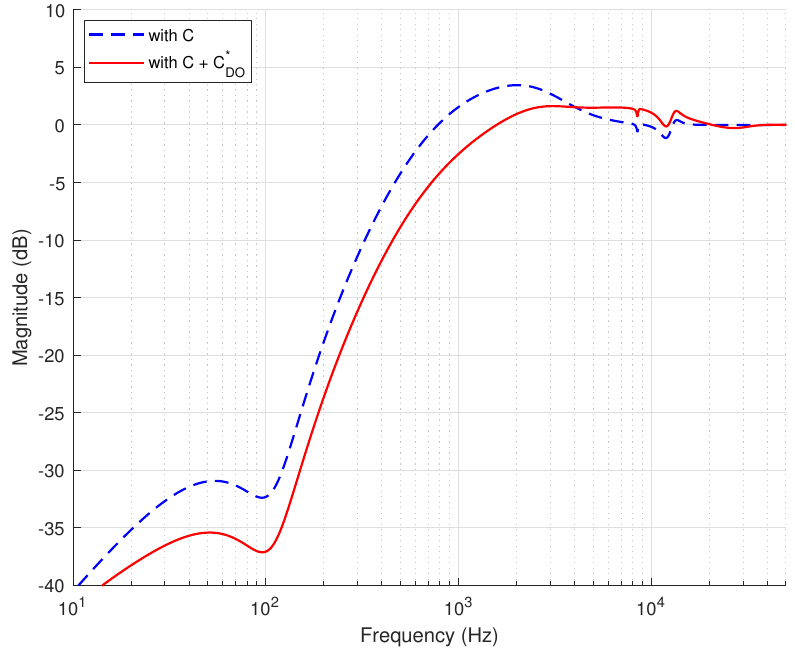
Figure 7. Designed sensitivity functions.